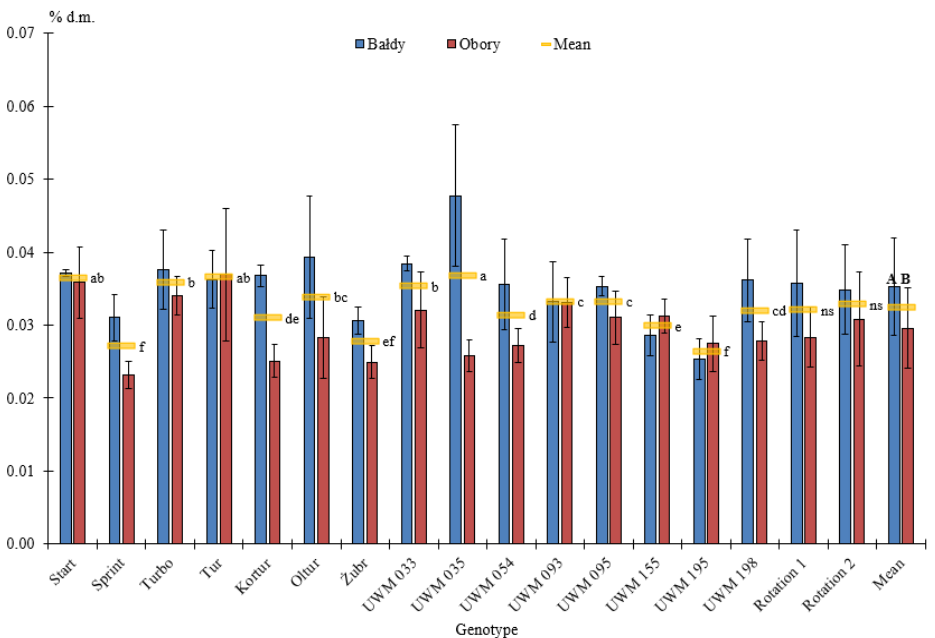
Figure 9. Sulphur content in the biomass of 15 willow genotypes obtained at two locations in two consecutive three-year harvest rotations; (legend: see Figure 1).